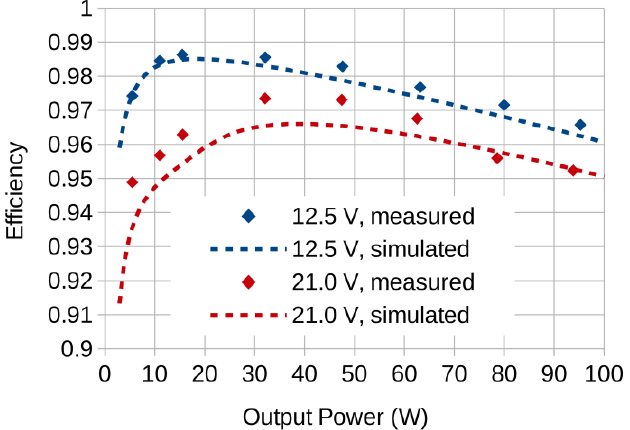
Figure 4. Simulated and measured MPC efficiencies as functions of its output power, for minimum and maximum input voltages (battery pack fully discharged or fully charged).